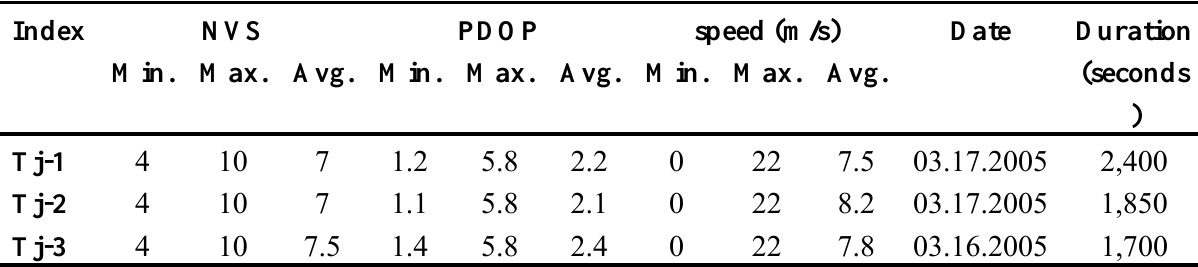
Table 1. The summary of experimental